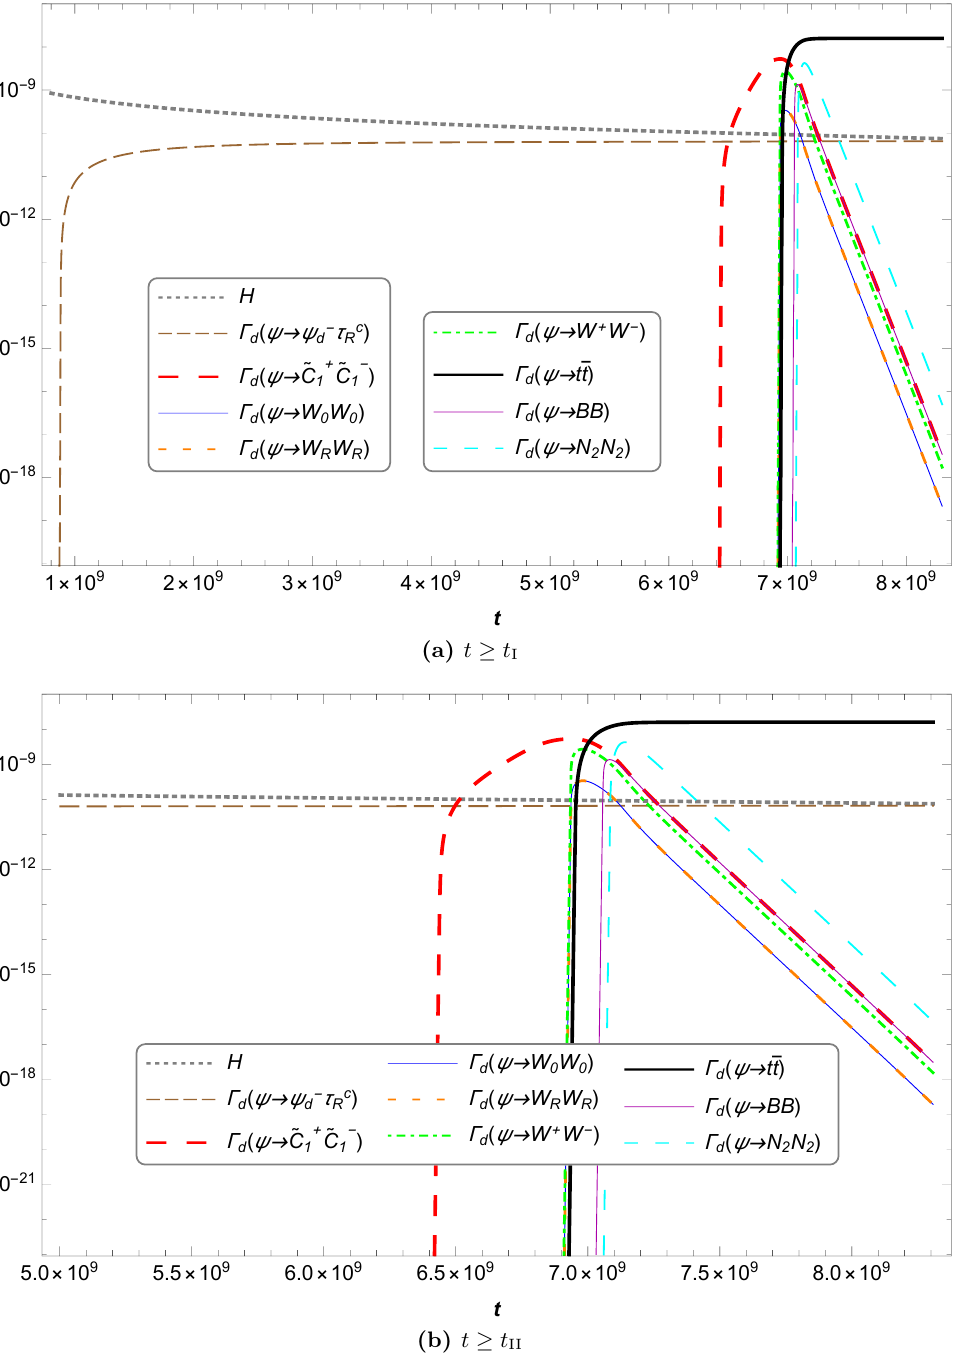
Figure 14. In (a), we plot the evolutions of H and the decay rates (cid:0) d;i from t I to sometime after the end of reheating. In (b), we plot H and (cid:0) d;i from t II to sometime after the end of reheating. Note that (cid:0) d ( ! (cid:0) (cid:28) c ) is very close to H when t > t II . We set t I = 8 (cid:2) 10 8 and t II = 5 (cid:2) 10 9 . In R d both (a) and (b), (cid:0)( ! ~ N 2 ~ N 2 ) is the total decay rate for three processes ! ~ N 2 a ~ N 2 a , ~ N 2 b ~ N 2 b , ~ N ~ N 2 a 2 b and we have set M P =